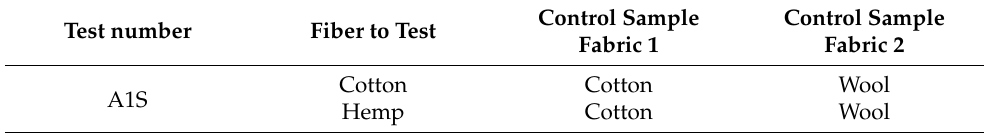
test conditions shown in Table 2. A color fastness tester Rotowash ® (SDL Atlas, Rock Hill, United States of America) and the control sample fabrics indicated in Table 3 were used. Table 2. The A1S test conditions according to UNE-EN ISO 105-C06:2010.